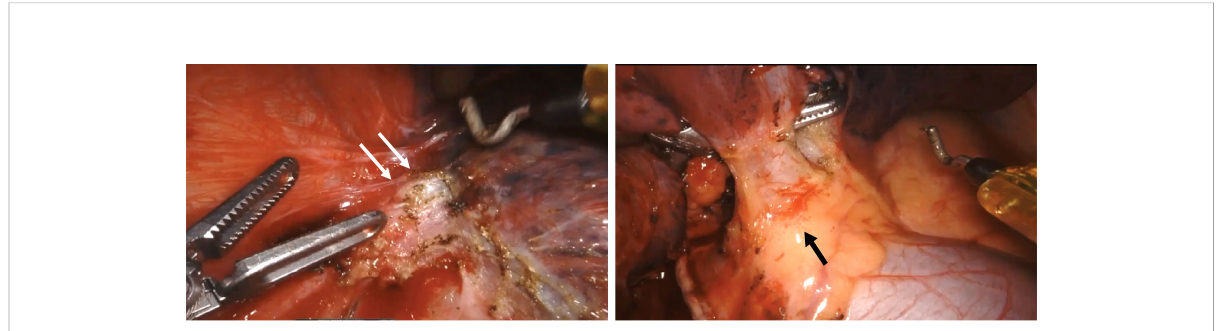
FIGURE 3 Representative intraoperative views of one patient (case 7) during robotic-assisted thoracic surgery. It showed adhesion and fi brosis (white arrow), edema, and microbleeds (black arrow) in the chest after neoadjuvant chemoimmunotherapy.